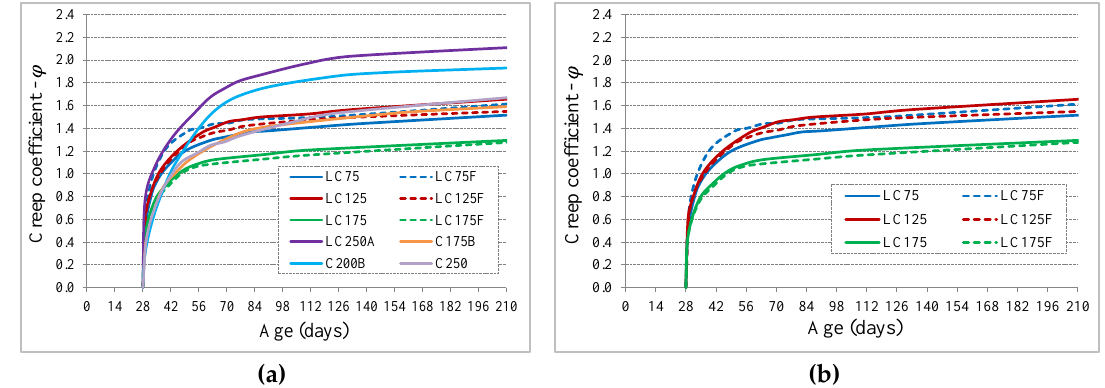
Figure 6. Evolution with age of creep coefficient: ( a ) all concretes; ( b ) concretes LC with different granulometric curves (LC-Funk and Dinger; LC_F-Faury).